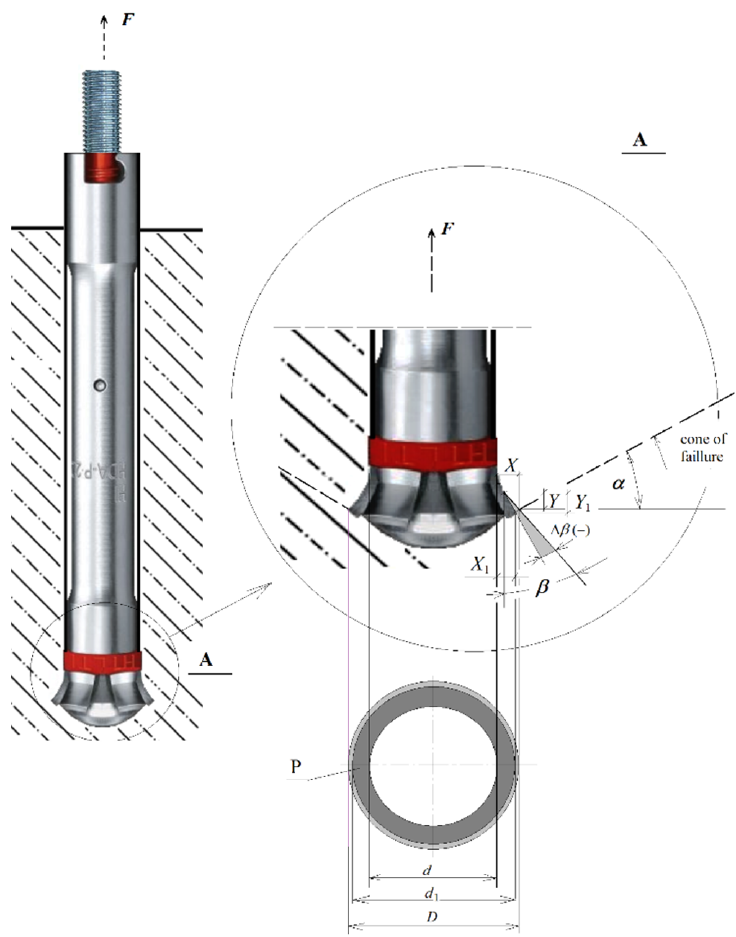
Figure 4. F —anchor pull-out force, β —the angle of rock cut with the undercutting head element equal to the angle of the cone of the undercutting head (more precisely, the angle of half the head cone), d —diameter of the anchor mounting hole, D —diameter of the undercutting of the rock with the head during assembly according to the producer’s recommendations, d 1 —undercutting diameter in case of wear undercutting head, ∆ β —the change of the undercutting head angle, P—active surface of the head in contact with rock (projection of the conical surface of the head in contact with rock on a surface perpendicular to the anchor axis), and x , x 1 , y , y 1 —coordinates of the base corner of the conical part of the head.